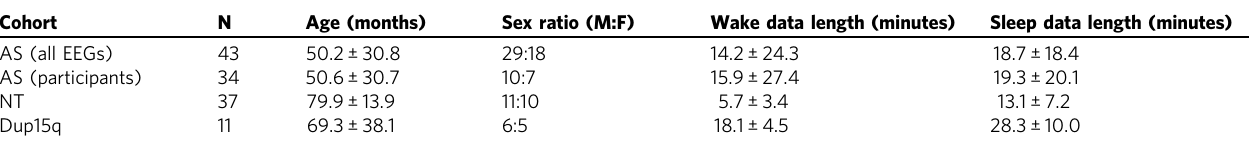
Age and data length are reported above as mean ± std. Because some participants with Angelman syndrome (AS) had multiple EEGs, we report separate descriptives for all EEGs ( fi rst row) and for uniqueparticipantsafter fi rstaveragingwithinparticipants(secondrow). N = 25participantswithAShadpartialdeletionsof15q,withtheremainingparticipantshavingotheretiologies,e.g., UBE3A point mutations. N = 26 participants with AS had one dataset retained following preprocessing, N = 7 participants had two datasets retained, and N = 1 participant had three datasets retained. N = 9 participants with Dup15q had an extranumerary chromosome (i.e., isodicentric duplication or tetrasomy 15q) while the remaining N = 2 participants had interstitial duplications (i.e., trisomy 15q). See Extended Data for channel-averaged EEG feature values, as well as age, sex, genotype, cohort, conscious state, and usable data length for each participant ’ s